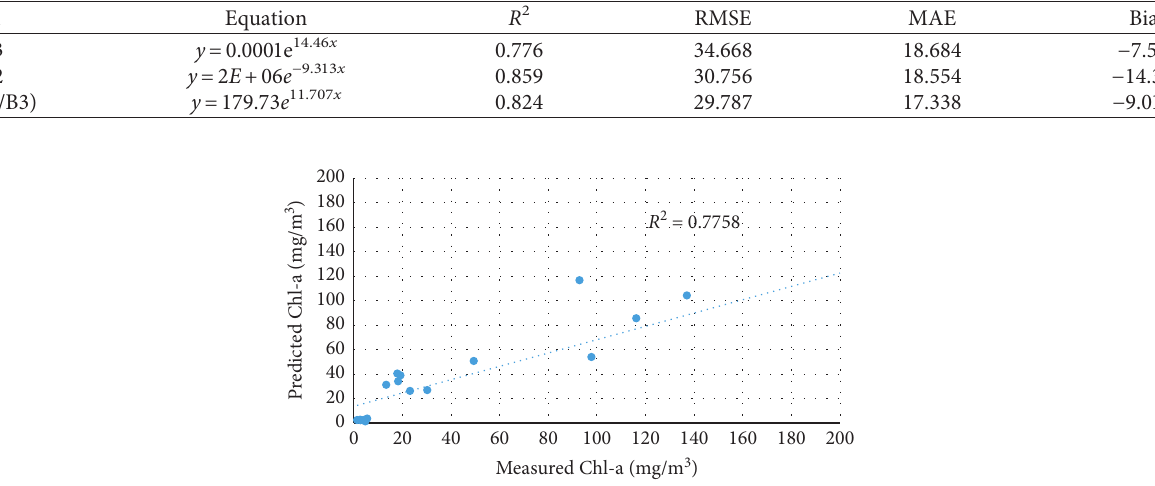
Figure 11: Regression between predicted and measured Chl-a using the B2/B3 model.